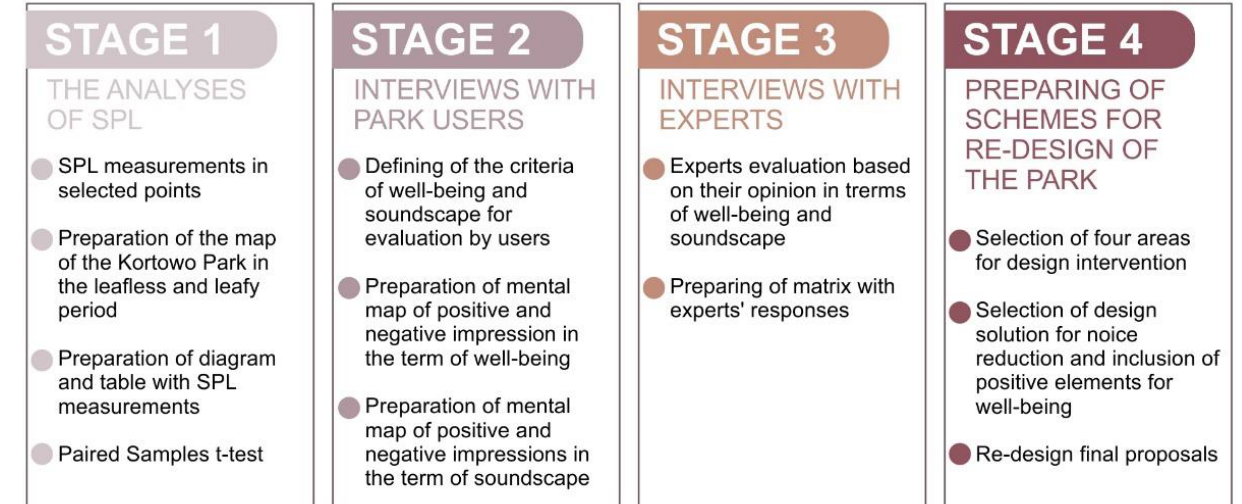
Figure 3. Main stages of the research.